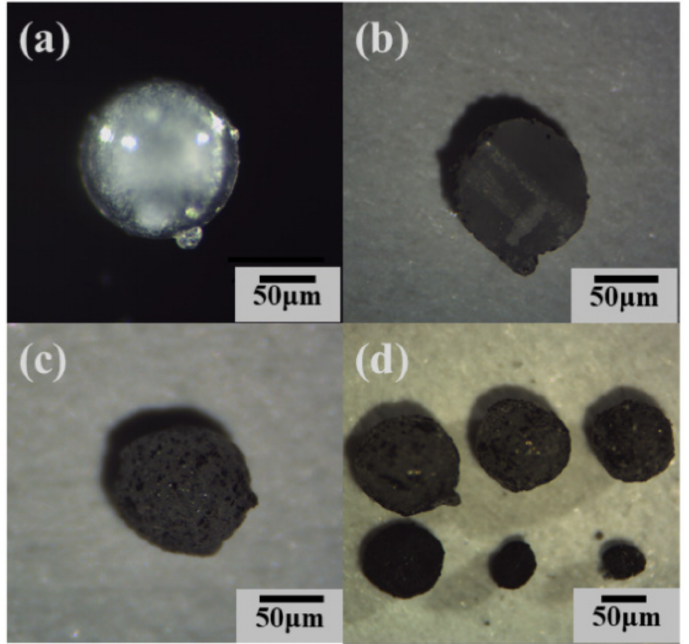
Figure 5. Stereomicroscope views of ( a ) MPCM-2, ( b ) MPCM-1 section, ( c ) MPCM-1, and ( d ) MPCM-1 of different